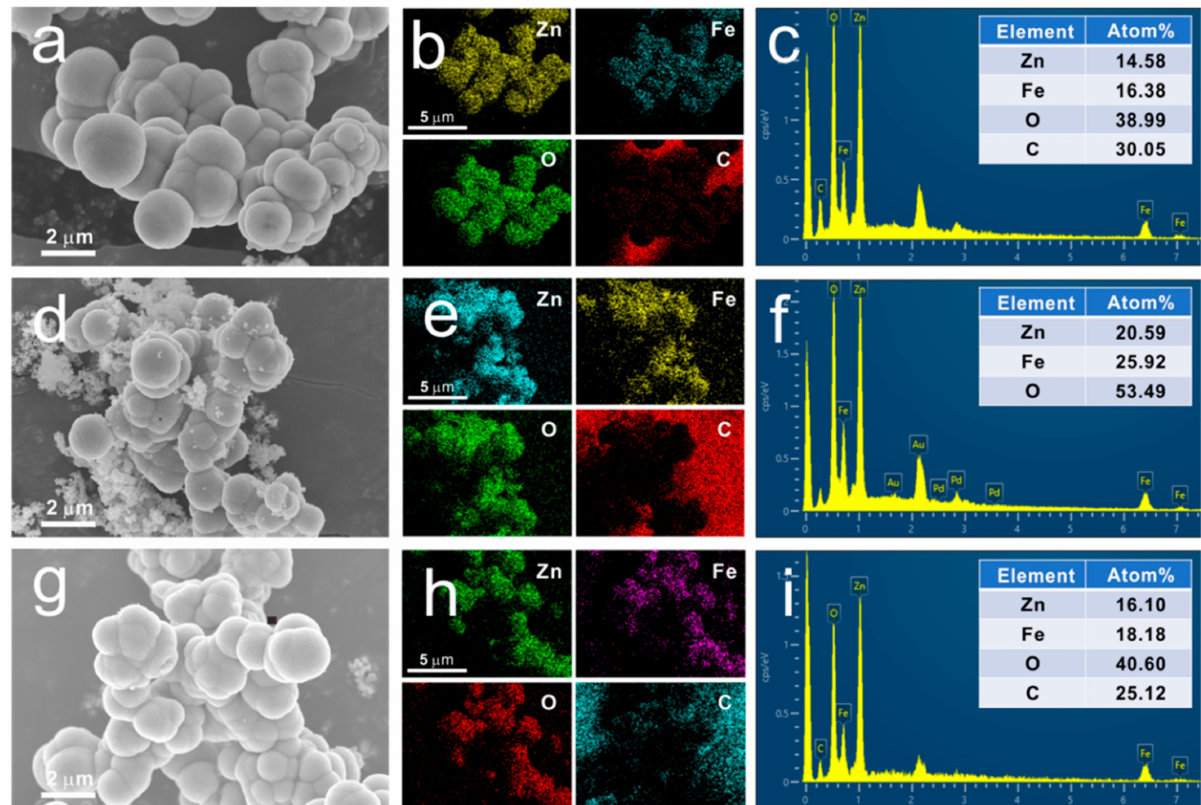
Figure 5. SEM images of S1 ( a ), S2 ( d ) and S3 ( g ); EDS mapping of S1 ( b ), S2 ( e ) and S3 ( h ); EDS spectra of S1 ( c ), S2 ( f ) and S3 ( i